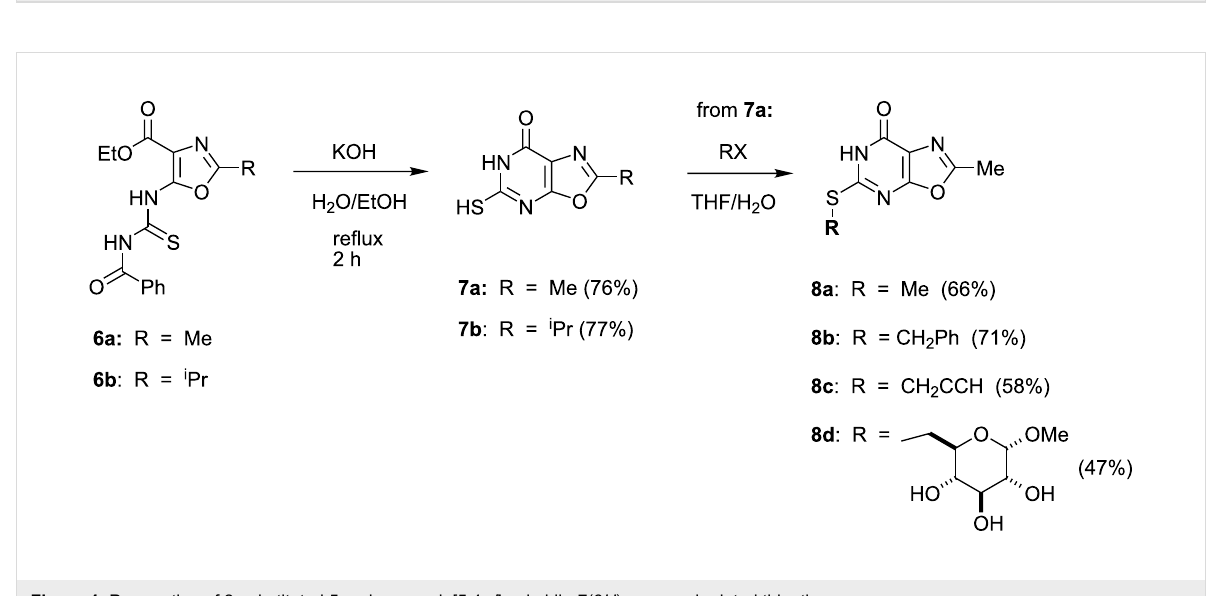
Figure 3: Preparation of 2-substituted 5-aminooxazolo[5,4- d ]pyrimidin-7(6 H )-ones.